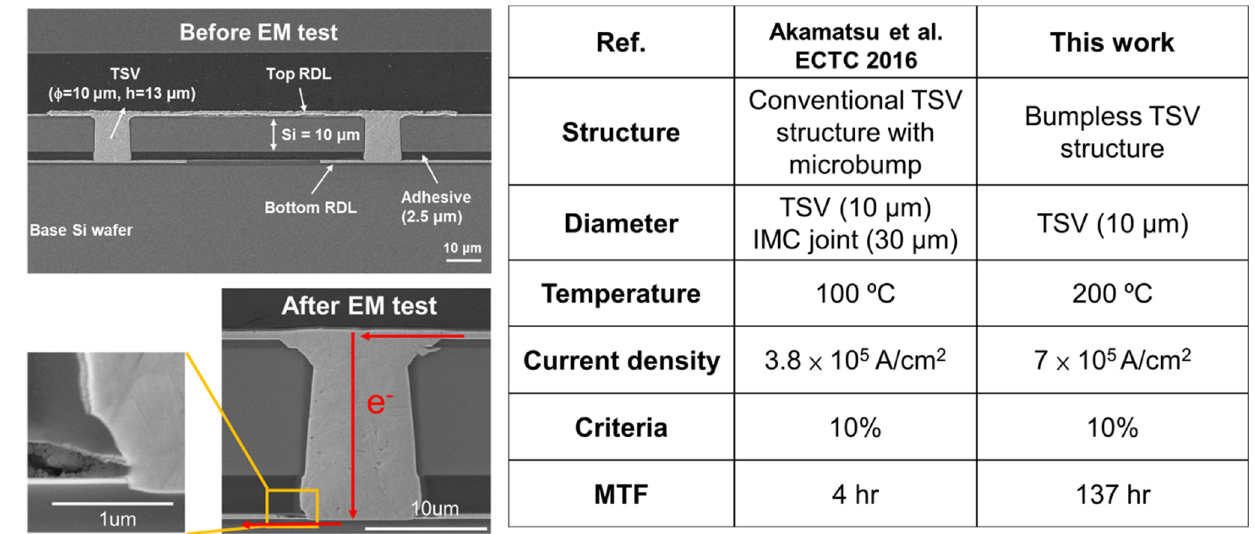
Figure 14. Cross-sectional SEM images of bumpless TSV interconnects before and after electromi- gration test (EM) ( left ). A comparison of electromigration characteristics between bumpless TSV structure and the conventional TSV with microbump ( right ) [71].